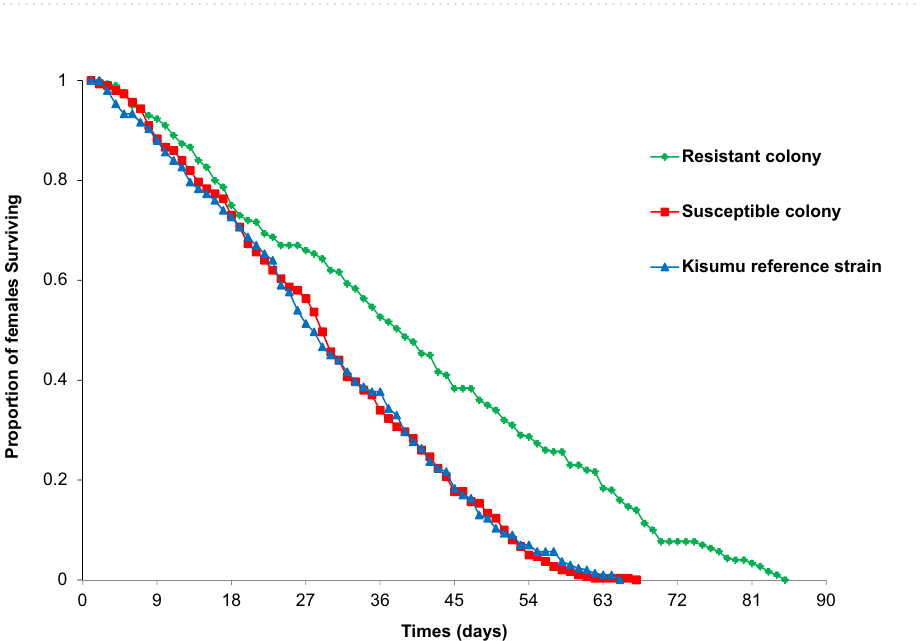
Figure 1. Comparison of survivorship among the resistant, susceptible and Kisumu strain An. gambiae